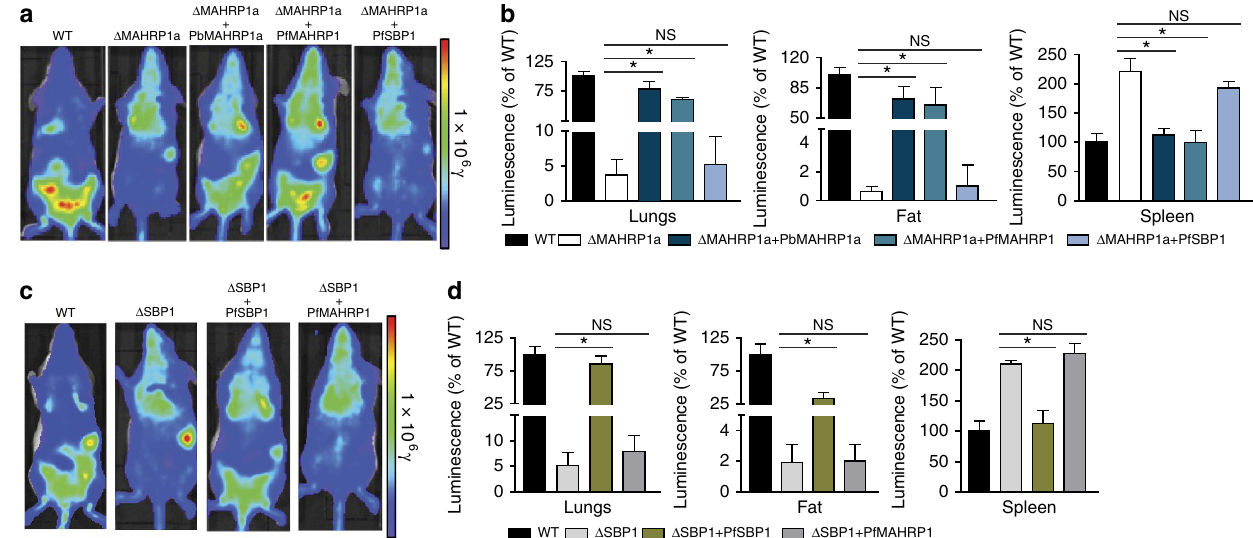
Figure 5 | Heterologous complementation of the mutants Pb D mahrp1a and Pb D sbp1 with Pf mahrp1 and Pf sbp1 rescues the schizont sequestration in vivo . Representative distribution of schizonts in mice infected with the matched and mismatched complementation of the Pb D mahrp1a ( a ) and Pb D sbp1 ( c ) parasites compared to wt and uncomplemented parasites (photons per s per cm 2 ; shown as radiance, y ). ( b , d ) quantification of parasite loads in isolated organs after perfusion (relative luminescence intensity (photons per s per cm 2 ) compared to wt-infected mice) obtained 22h after establishing synchronised infections with luciferase-expressing wt, mutant and complemented parasites ( n ¼ 9 mice per group; * P o 0.0001, one-way ANOVA, Tukeys post hoc